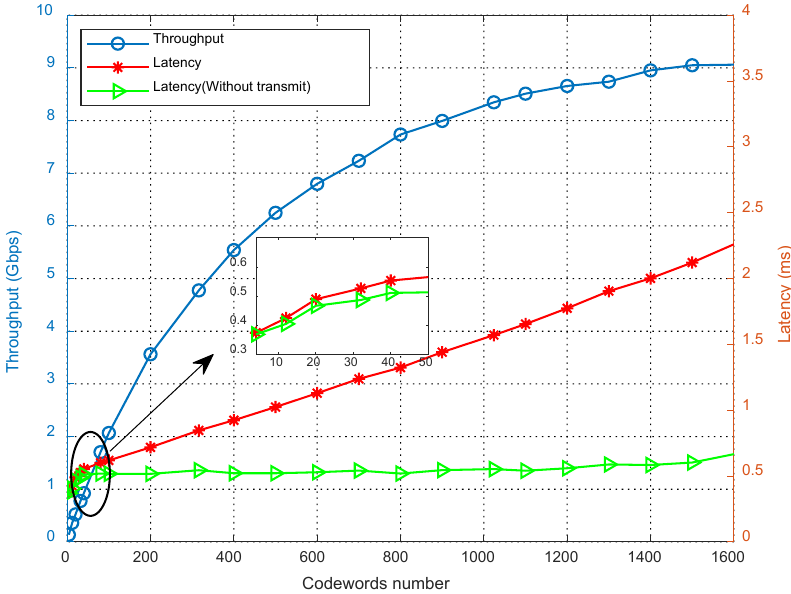
Figure 10. The throughput and latency curve of the proposed decoder with different numbers of codewords. The decoding latency without a transmission delay is also displayed in Figure 10.